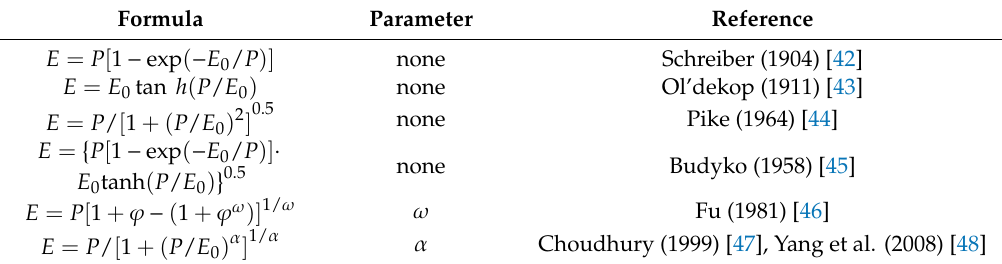
Table 1. Di ff erent forms of solutions to the Budyko